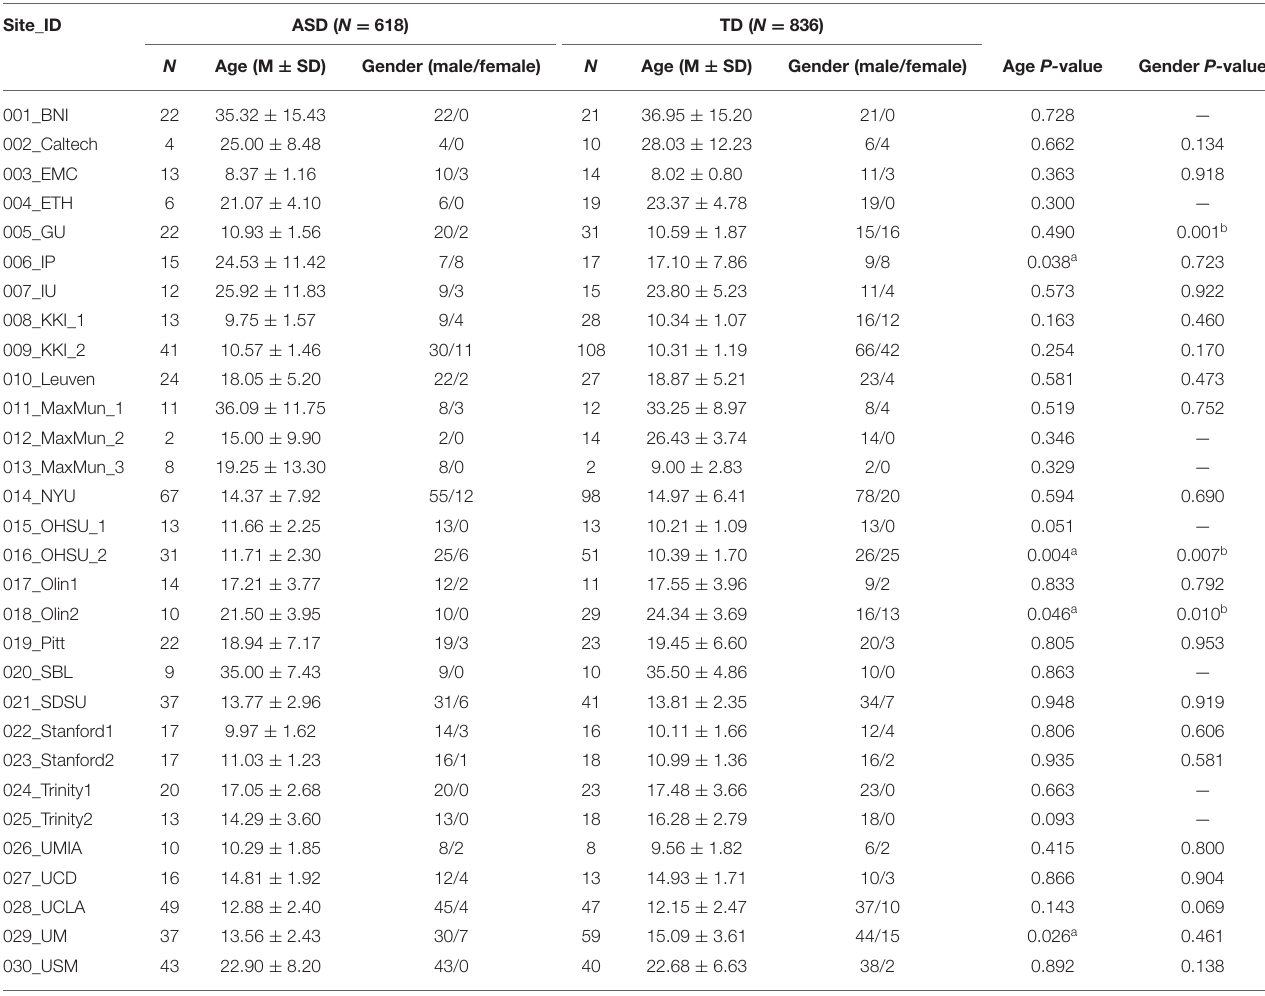
TABLE 1 | Demographic characteristics of ASD and